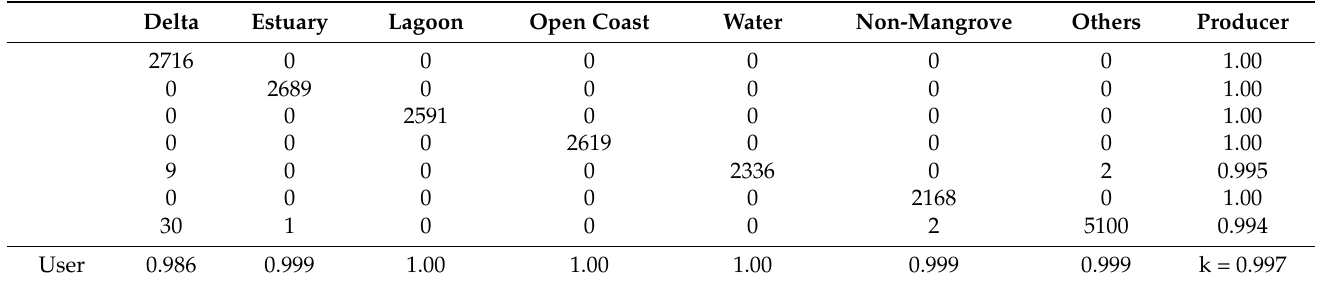
Table 3. Confusion matrix of the random forest classifier, with relative producer and user accuracies and kappa coefficient. The accuracy was assessed on a 70–30 split between the training and the test set.